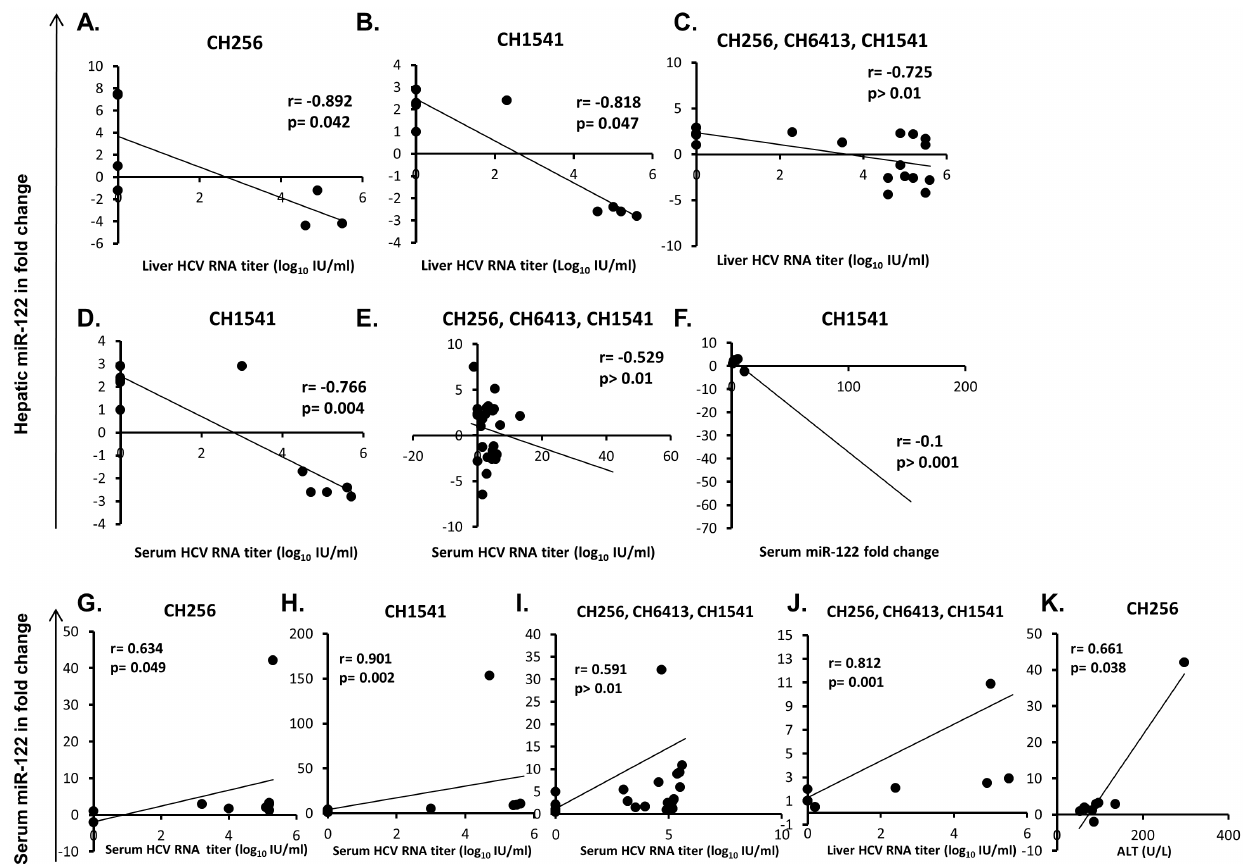
Figure 2. Acute HCV infection in chimpanzees. Hepatic and serum miR-122 statistically significant correlation with liver, serum HCV RNA titers, and ALT activity. Hepatic miR-122 vs. HCV RNA titer in the liver in CH256 (A); in CH1541 (B); in CH256, CH6413, CH1541 (C); vs. HCV RNA titer in serum in CH1541 (D); in CH256, CH6413, CH1541 (E); vs. serum miR-122 in CH1541 (F). Serum miR-122 vs. HCV RNA titer in serum in CH256 (G); in CH1541 (H); in CH256, CH6413, CH1541 (I); vs. HCV RNA titer in the liver in CH256, CH6413, CH1541 (J); vs. ALT activity in CH256 (K).